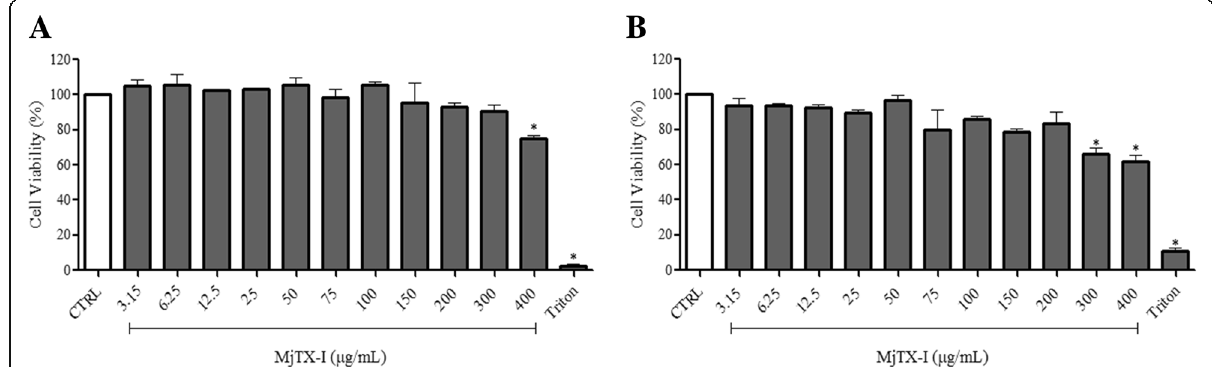
Fig. 2 Cytotoxicity of MjTX-I towards ( a ) HEK-293 and ( b ) PBMC non-tumor cells. Results are expressed as the mean percentage of cell viability ±